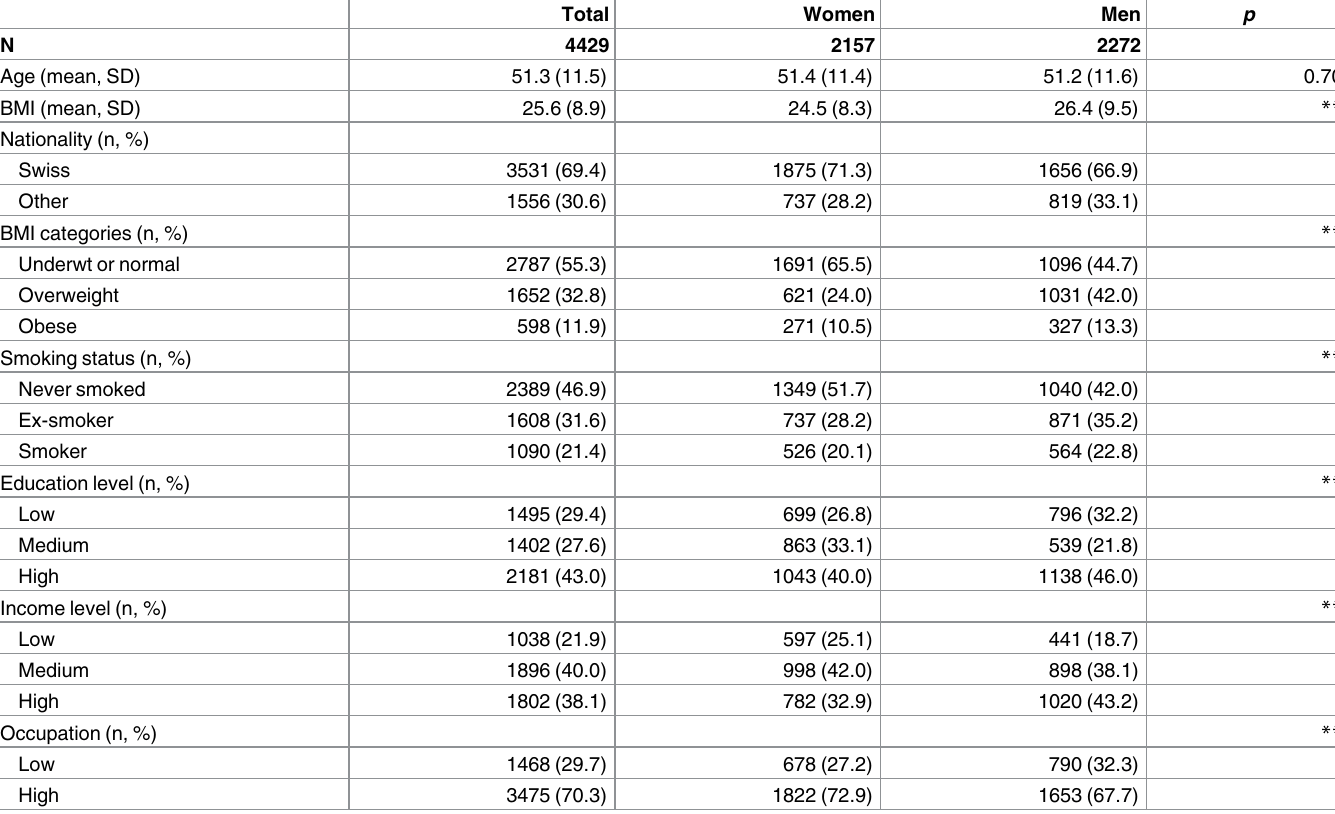
Table 1. Characteristics of included participants from “Bus Sante´” study, Geneva, Switzerland,